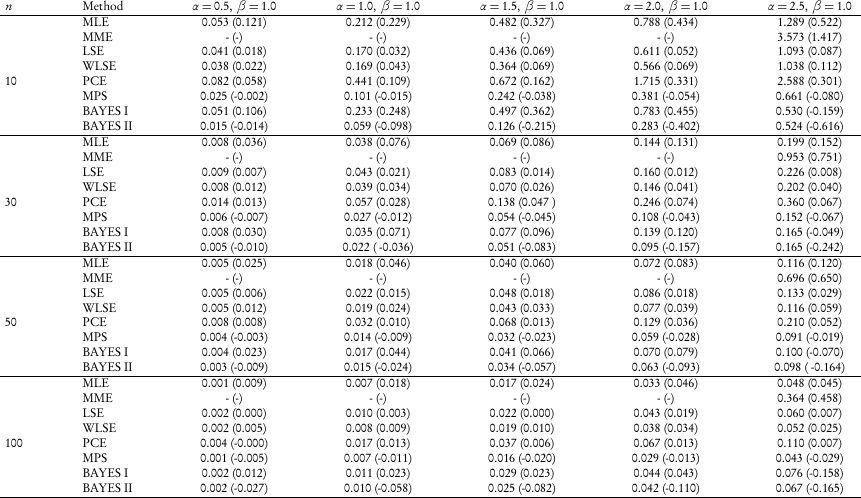
MSEs and average biases (values in parentheses) of different estimates of α